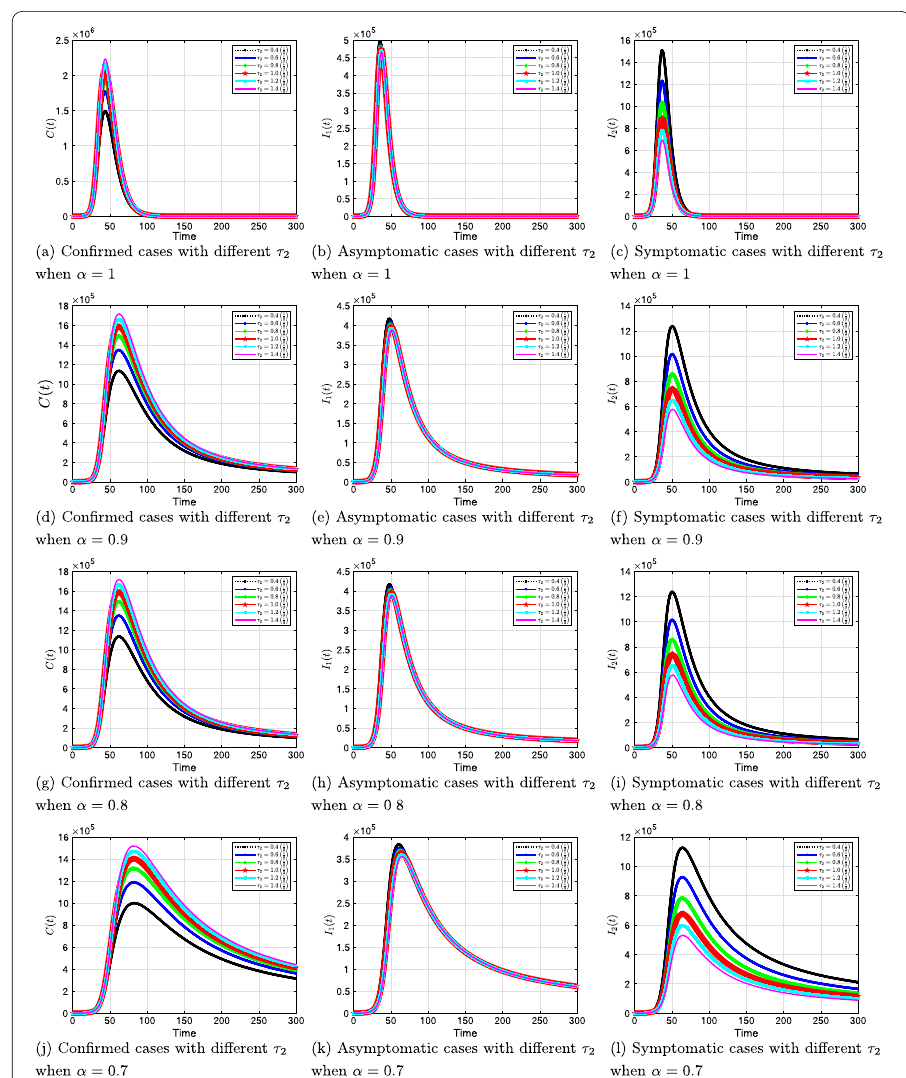
Figure 11 Solution profiles for the COVID-19 model with different τ 2 across different fractional order